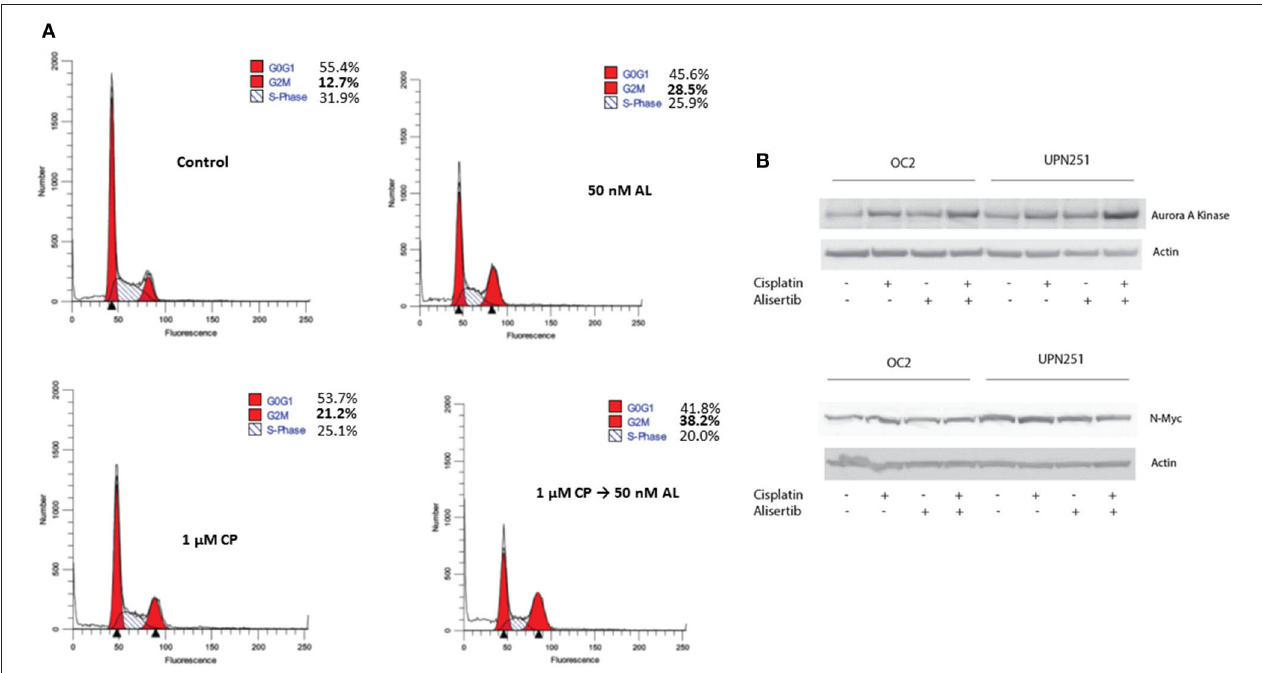
FIGURE 3 | Alisertib enhances accumulation of cells in G 2 /M following cisplatin treatment. (A) UPN251 cells were treated with cisplatin (CP), for 3h followed by 50nM alisertib for 48h. Following treatment cells were stained with and propidium iodide and analyzed by flow cytometry. (B) OC2 and UPN251 cells were treated as in Figure 2A and cell lysates prepared following drug treatment. Lysates were analyzed by SDS-PAGE and probed for expression of AAK, N-myc, and